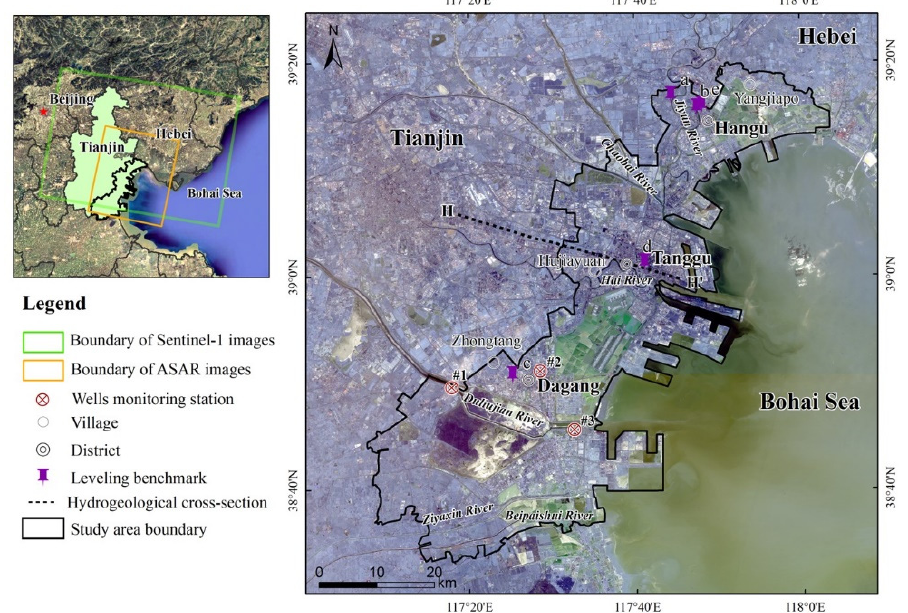
Figure 1. Distribution of the study area. The yellow box indicates the boundary of the ENVISAT ASAR images (track 175, frame 2817), and the green box indicates the boundary of the Sentinel-1 images (path 149, frame 463) used to map land subsidence. The positions of the leveling benchmarks and wells monitoring station are provided. The black dashed line shows the hydrogeological cross- section. The background is a Sentinel-2 image acquired on 16 September 2020.